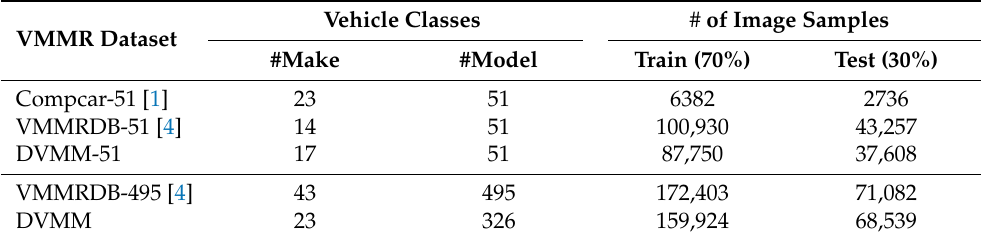
Table 2. VMMR Dataset Specifications.